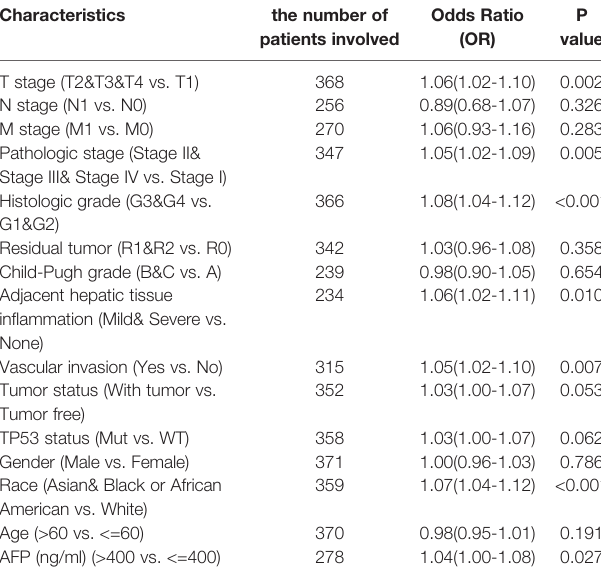
PPI network of METTL18-related genes was performed, and the results indicated that diverse biological processes and signaling